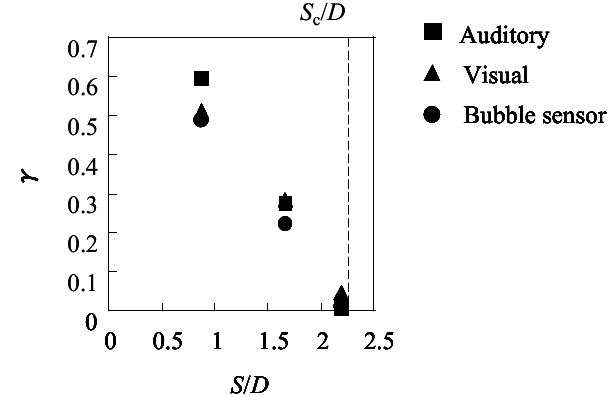
Fig.10 Intermittency factor γ versus S / D （ X / D ＝ 1.71 ） .